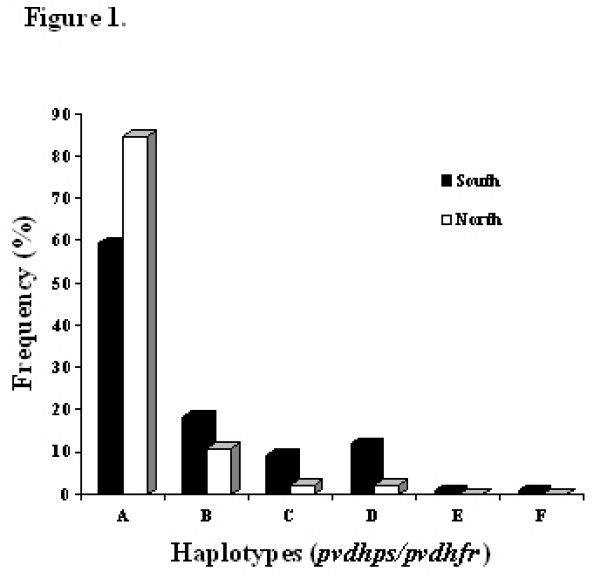
Frequency distribution of the combination pvdhfr/pvdhps haplotypes obtained from 189 isolates collected in Ardebil province in north and Sistan and Baluchistan province in southeastern of Iran. The haplotype I13P33F57S58T61S117I173/A383A553 was the most prevalent among northern (84.8%) and southern (59.4%) P. vivax isolates. All six haplotypes are indicated as A to F in the figure. Mutated amino acids are boldfaced. A) I13P33F57S58T61S117I173/A383A553. B) I13P33F57S58T61N117I173/A383A553. C) I13P33F57R58T61S117I173/A383A553. D) I13P33F57R58T61N117I173/A383A553. E) I13P33L57S58T61S117I173/A383A553. F) I13P33L57R58T61S117I173/A383A553.